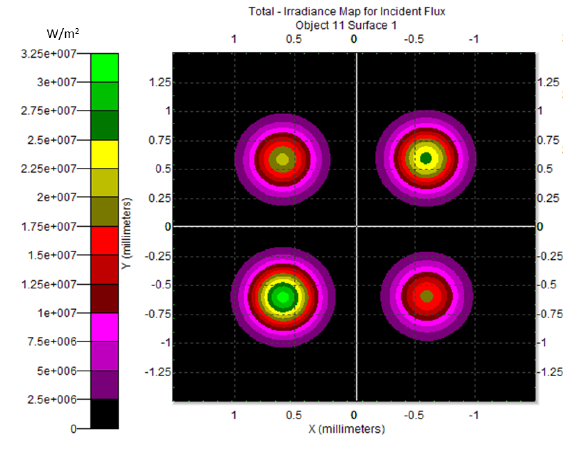
Figure 7. Light flux distribution on the CCD in optical